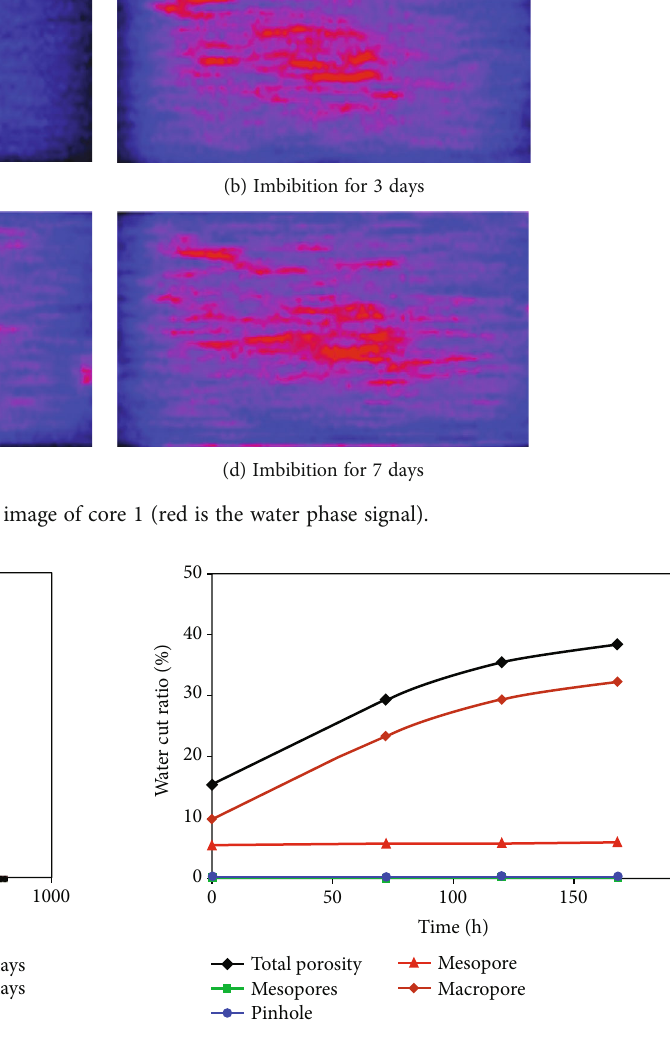
Figure 6: Variation curve of water cut of di ff erent types of pore- throat in core 1 with imbibition